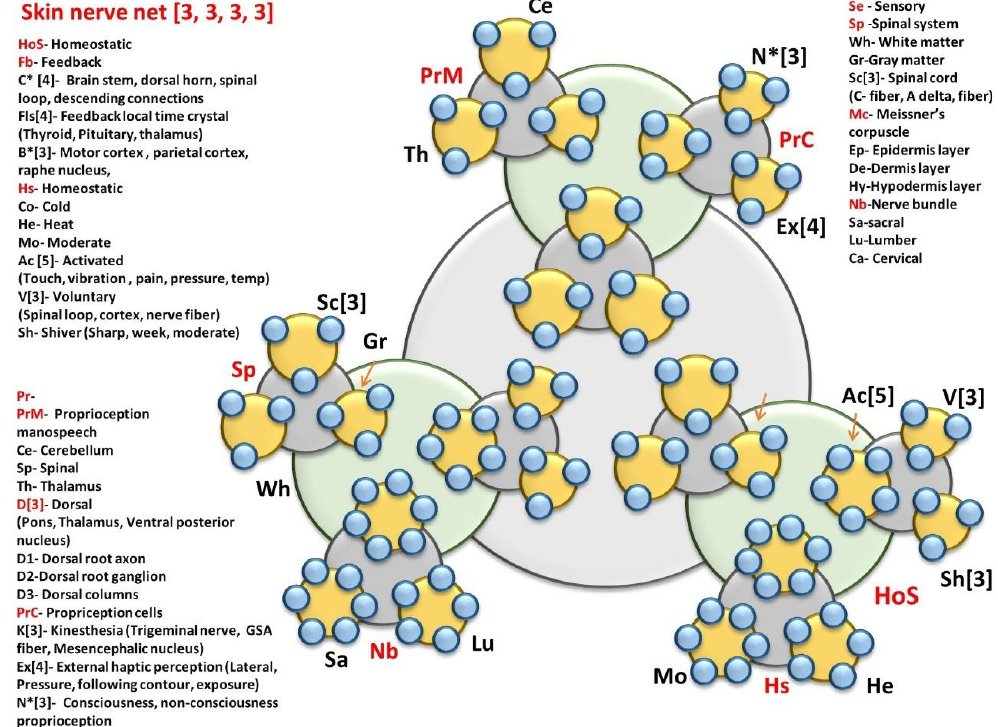
Figure 6. 2D clock architecture or time crystal representation of the skin nerve network of the body [41].